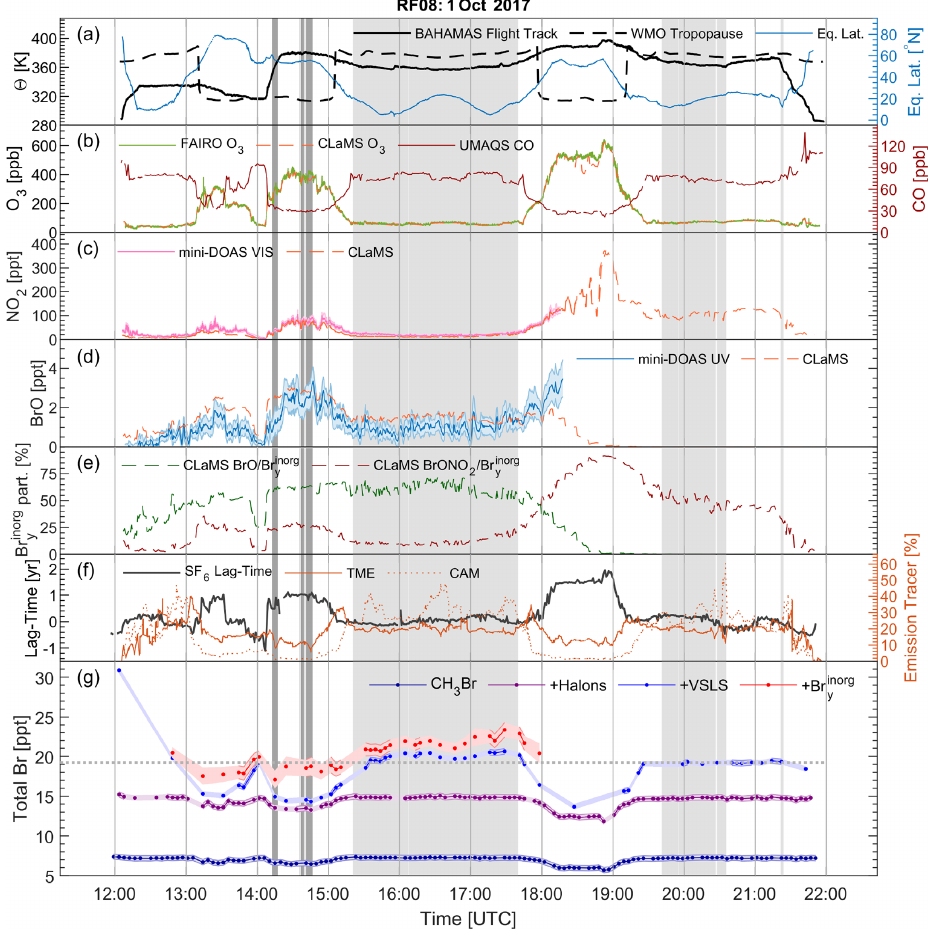
Figure 3. Overview of HALO RF08 on 1 October 2017 (dashed yellow flight track in Fig. 1). Panels (a–g) are as given in Fig. 2. Light gray shading indicates flight sections in the tropical (cid:50) high –PV low region ( (cid:50) > 355K and PV < 2PVU, i.e., former tropical UT/TTL air), and the dark gray shading indicates flight sections in the HBrR as discussed in the text. At SZA > 89 ◦ , mini-DOAS measurements (NO 2 , BrO, and Br inorg y ) are unavailable due to the lack of